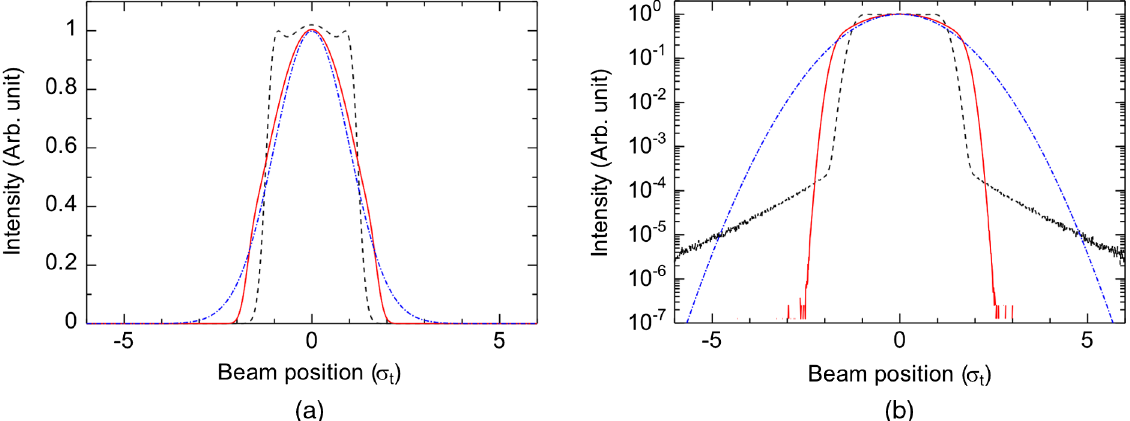
FIG. 5. Transverse beam distributions for the best flat case for 1 σ scales, respectively. Also, the distribution with the minimum beam loss case for outside of 2 . 5 σ width are shown as solid red and dotted lines, respectively. The intensity is normalized by the peak intensity given by the linear optics.